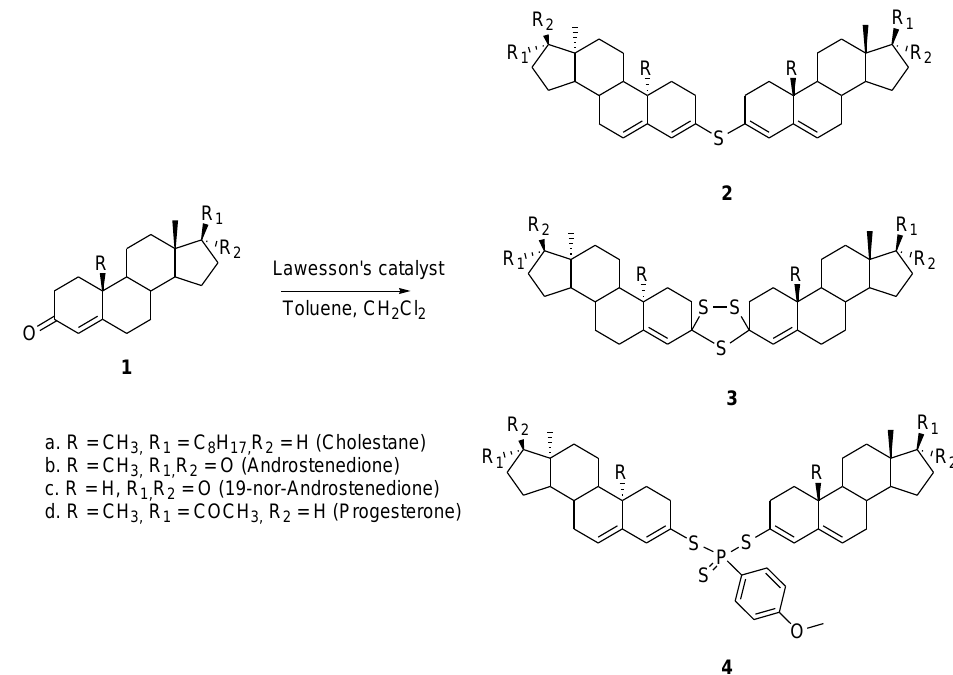
Figure 2. Synthesis of symmetric ( 3 , 4 ) and asymmetric ( 4 ) steroid dimers with a sulfur-based bridge.